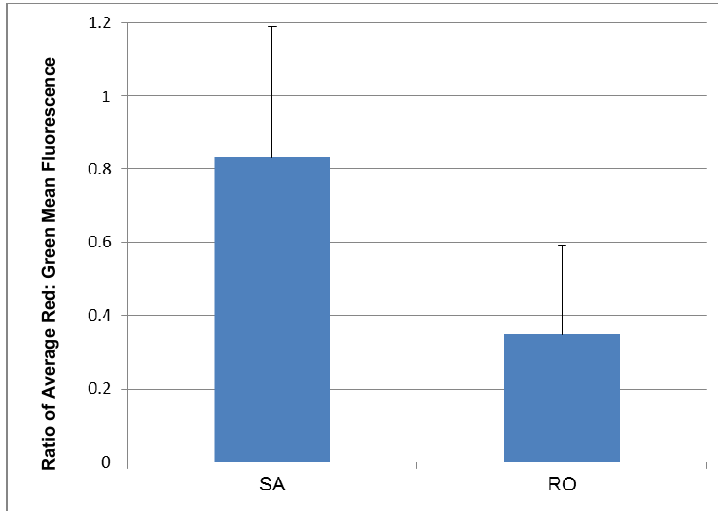
Figure 7. Chitosan Comparison of the average red: green channel mean fluorescence ratio between chitosan (CHI)/hyaluronan (HA)/fluorescein (6-FAM) DNA films containing either sulforhodamine B aptamer (SA) or RO DNA ( N = 11) as an indication of binding. Films were prepared by the original method of deposition and exposed to 200 µM SB dye. Error bars represent standard deviation. Difference between the ratios is statistically significant ( p <